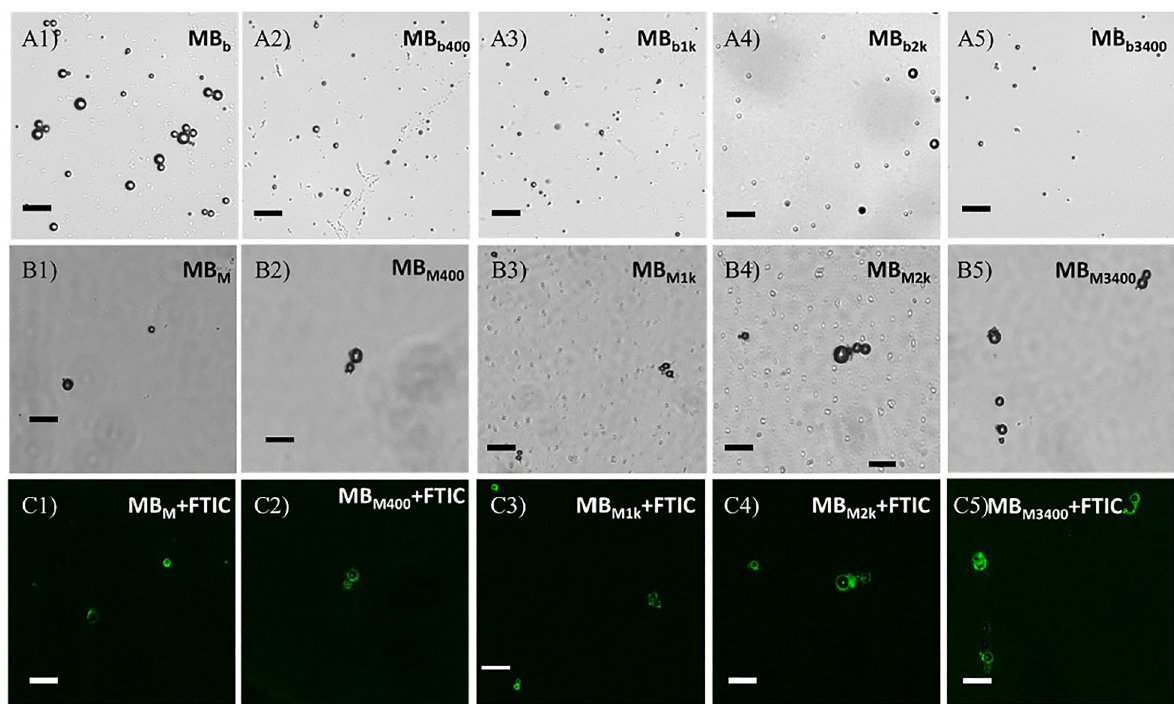
Figure 3: (A1 – A5) The bright-field images of biotinylated MBs with different PEG chain lengths (no PEG spacer arm, MBb; with PEG400, MBb400; with PEG1000, MBb1k; with PEG2000, MBb2k and with PEG3400, MBb3400) and (B1 – B5) the corresponding magnetic MBs (MBM, MBM400,MBM1k,MBM2kandMBM3400).(C1 – C5)ThefluorescentimagesofFITC-labeledmagneticMBswithdifferentPEGchainlengths.The scale bar is 5 μ